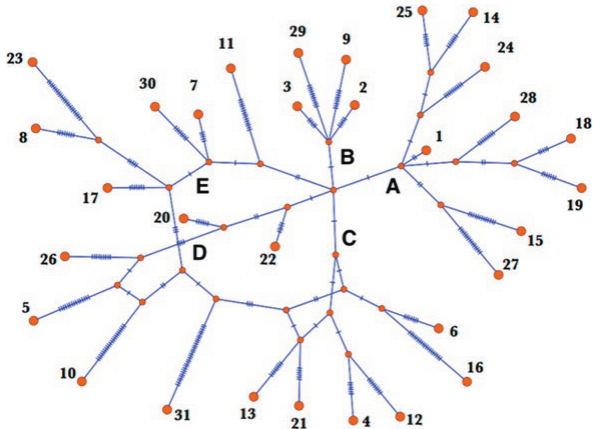
Figure 1. TCS network of the studied sequences showing five major haplotype